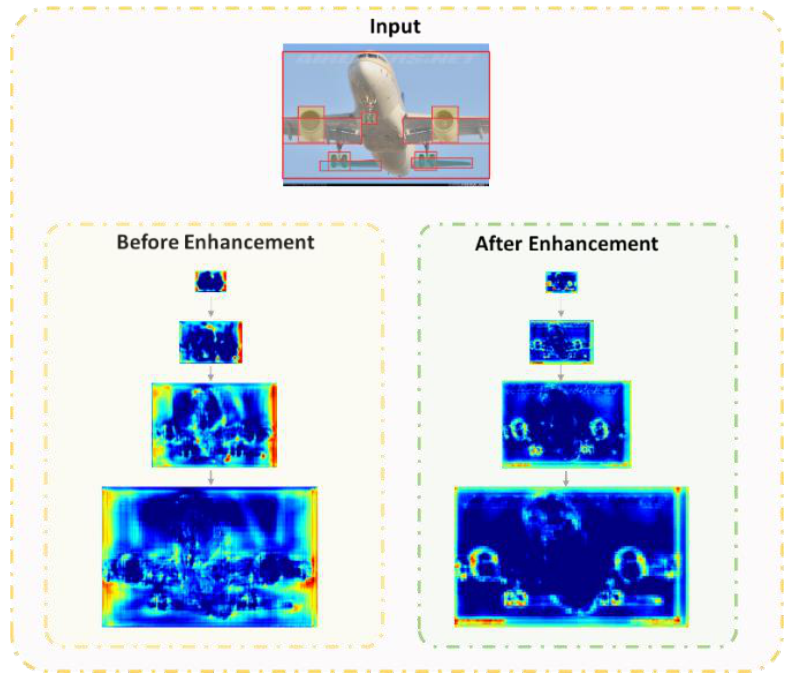
Figure 5. The performance of BFPCAR for feature enhancement.